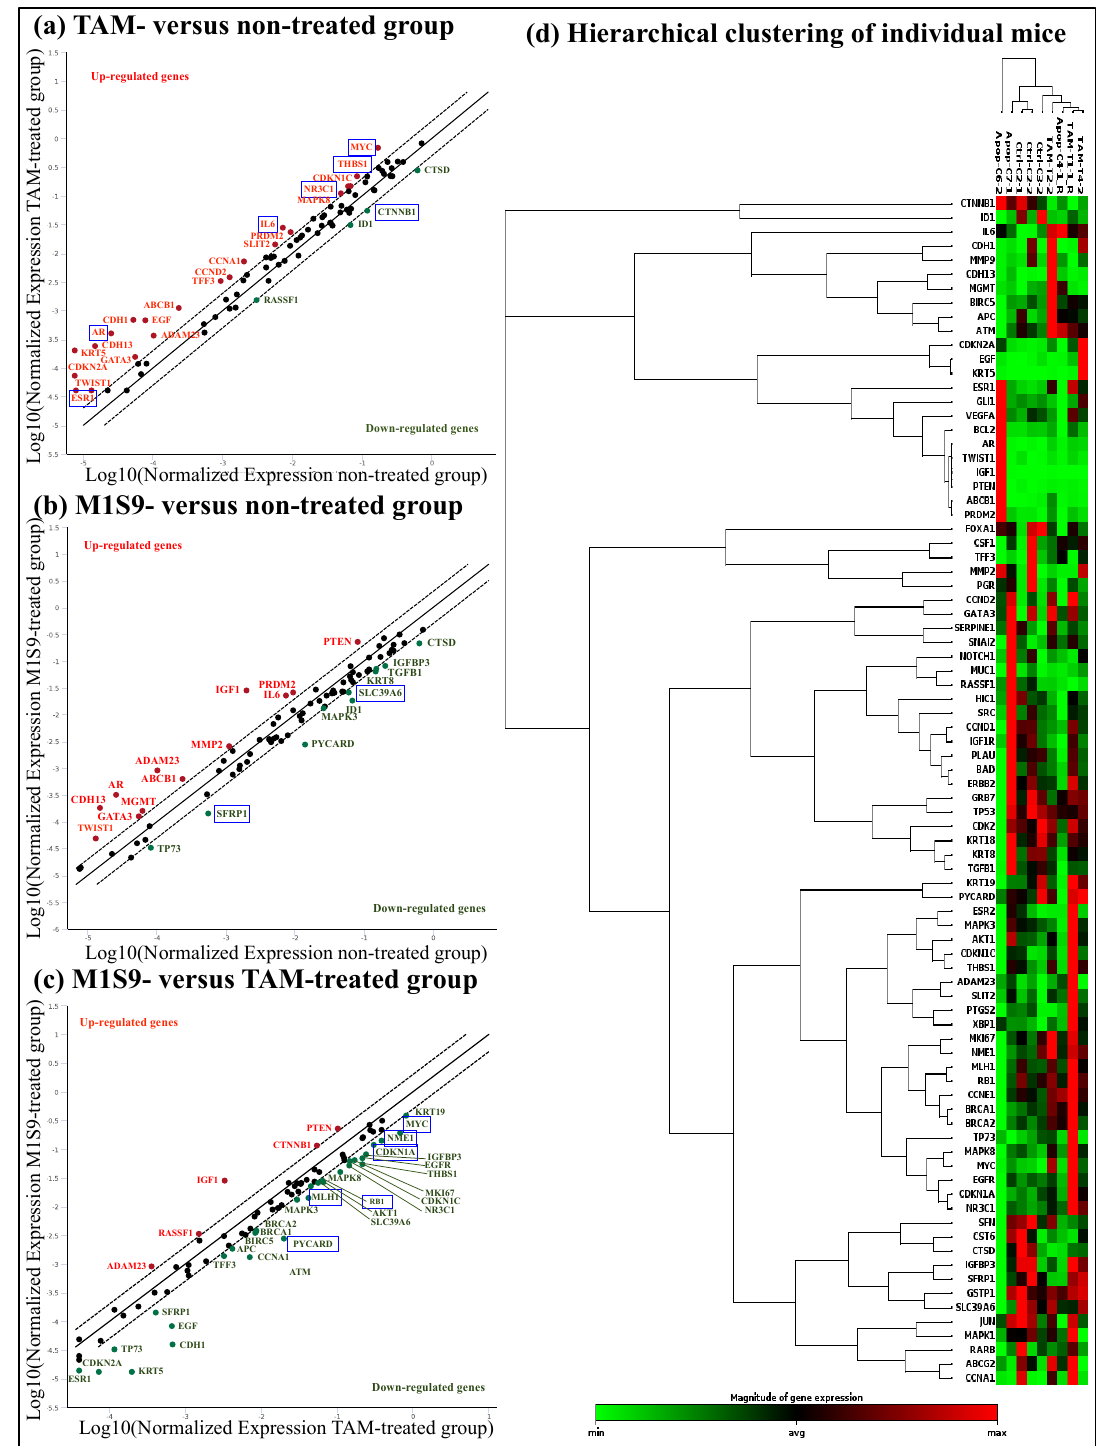
Figure 2. Effect of M1S9 on the expression levels of 84 key human breast cancer genes in MDA-MB-231 xenograft tumor: ( a ) TAM-treated versus non-treated group; ( b ) M1S9-treated versus non-treated group; ( c ) M1S9-treated versus TAM-treated group; ( d ) hierarchical clustering of individual mice. Upregulated genes (red characters) and downregulated genes (green characters) have fold changes ≥ ±2. Blue bracket indicates genes with significant difference at p < 0.05. Abbreviation: TAM—tamoxifen.